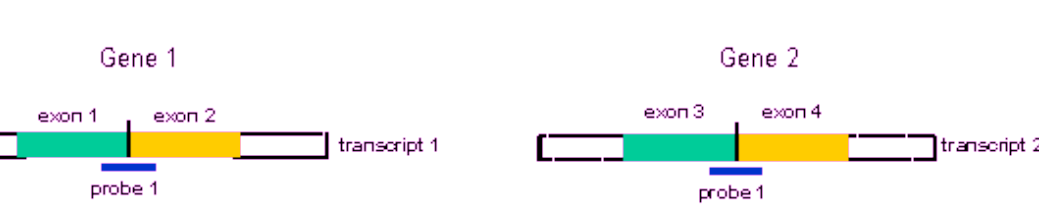
Figure 4: An example of a probe not considered to be mapping uniquely to an exon-exon junction. Probe 1 maps to two junctions from di ff erent genes (Gene 1 and Gene 2).